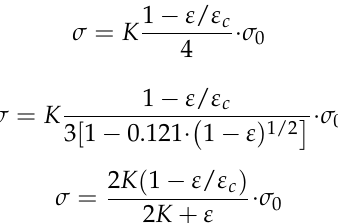
Table 1. Experimental data from Zhou et al. [40] and calculated values of electrical conductivity of sintered copper fibres using different models.